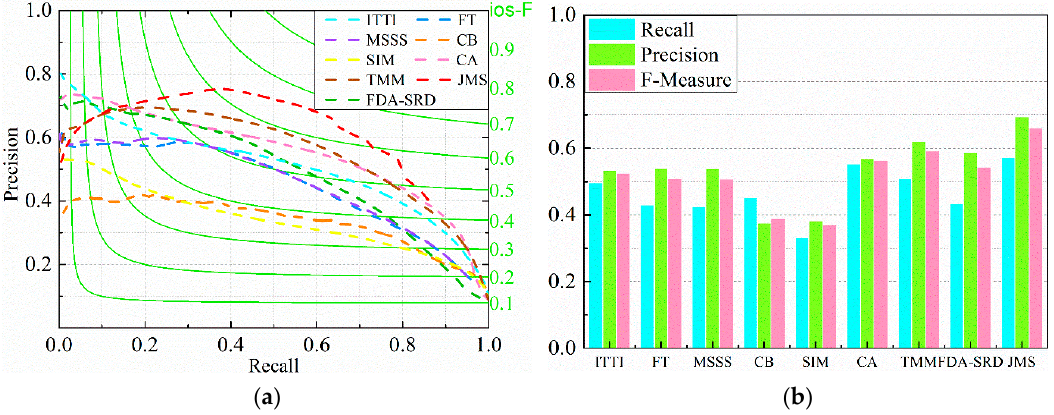
Figure 17. PRF comparison in ROI detection effectiveness. ( a ) Precision-recall curves; ( b ) the maximum F-Measure histogram.